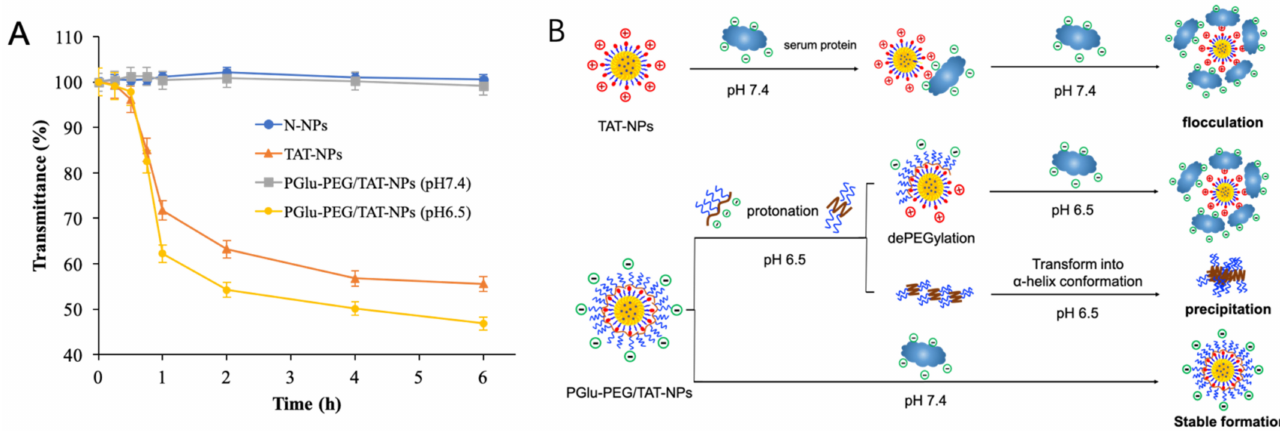
Figure 3. Stability of DSF-loaded nanoparticles in plasma. ( A ) Turbidity changes of N-NPs, TAT-NPs and PGlu-PEG/TAT- NPs pretreated with PBS containing 50% rat plasma of pH 7.4 and pH 6.5 ( n = 3). ( B ) Supposed schematic illustration of the interaction between serum protein and DSF-loaded nanoparticles. N-NPs, DSF-loaded naked nanoparticles; TAT-NPs, DSF-loaded cationic nanoparticles; PGlu-PEG/TAT-NPs, DSF-loaded shell/core composite